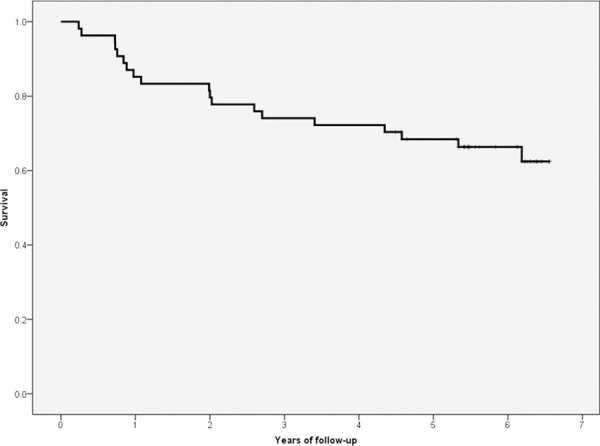
Overall survival.